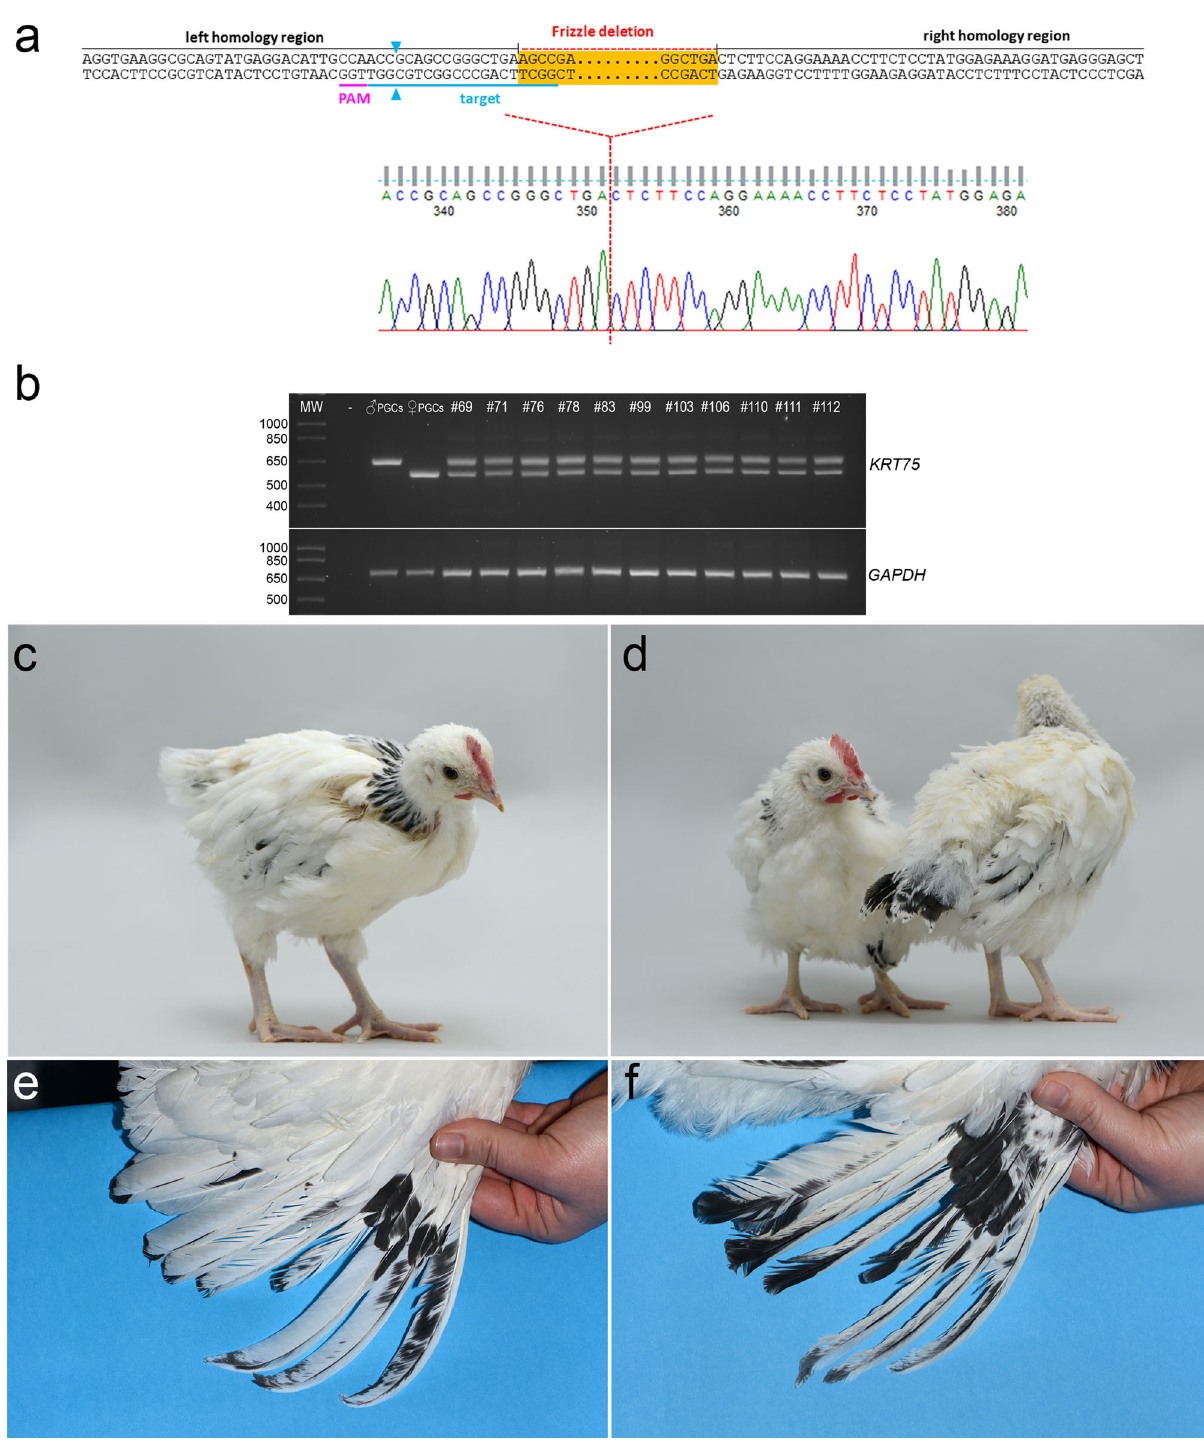
Fig. 5 Genome edit to introduce the FRZ allele into the LSX chicken breed. a KRT75 locus surrounding the FRZ mutation. A single guide (blue) that targets cleavage 12 bp from the intended deletion was transfected along with a ssODN containing 50 bp homology on each side of the deletion. A sequencing chromatogram shows the bi-allelic deletion in female LSX PGCs. b PCR analysis of KRT75- edited LSX PGCs and G 1 offspring from iCaspase9 hosts. The wild-type locus produces a PCR product of 657 bp. The edited locus produced a PCR product of 573 bp, n = 11. c , e Control 6-week-old offspring and wing (18 weeks) from LSX birds. n = 10/10 female birds. d , f FRZ heterozygote LSX G1 offspring (6 weeks) and wing (18 weeks) displaying crumpled fl ight feathers, n = 5 of 5 female birds. All photographs of live birds at The Roslin Institute.